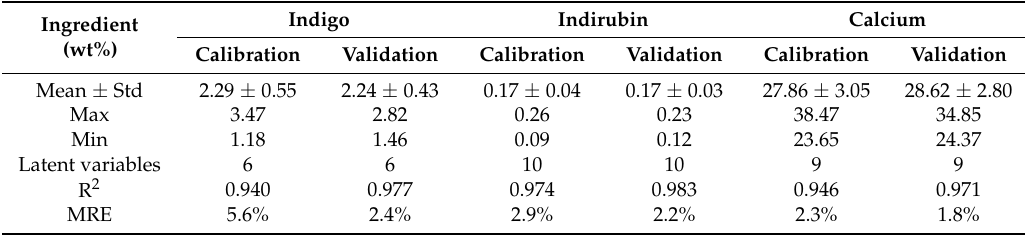
Table 2. Performance of the ATR-FTIR quantification models of Indigo